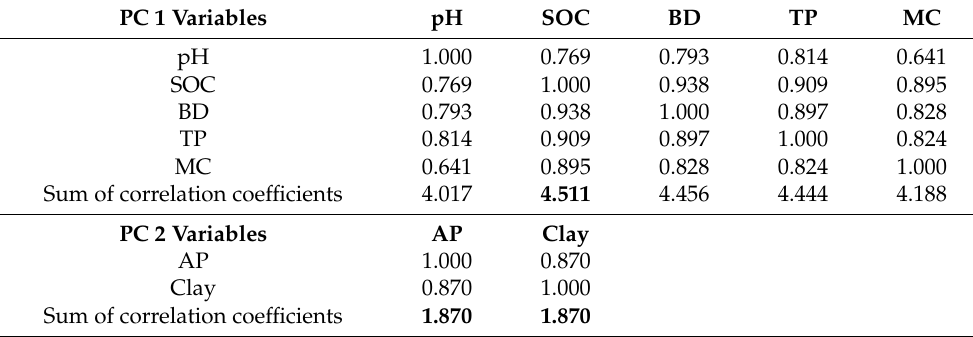
Table 4. Correlation coefficients and sums of highly weighted soil parameters in a particular principal component (PC).